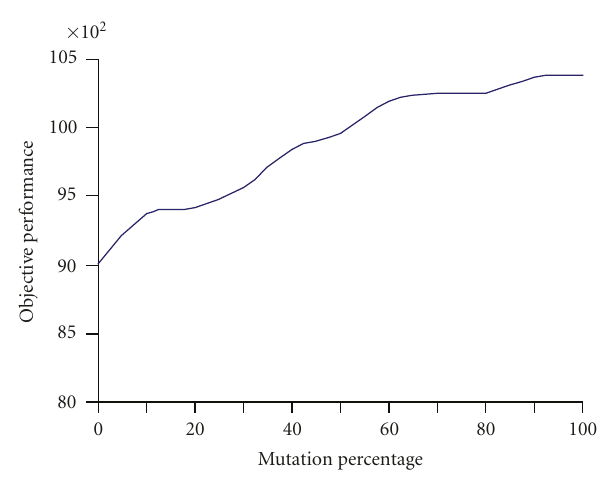
Figure 11: GA performance with di ff erent mutation percentages.